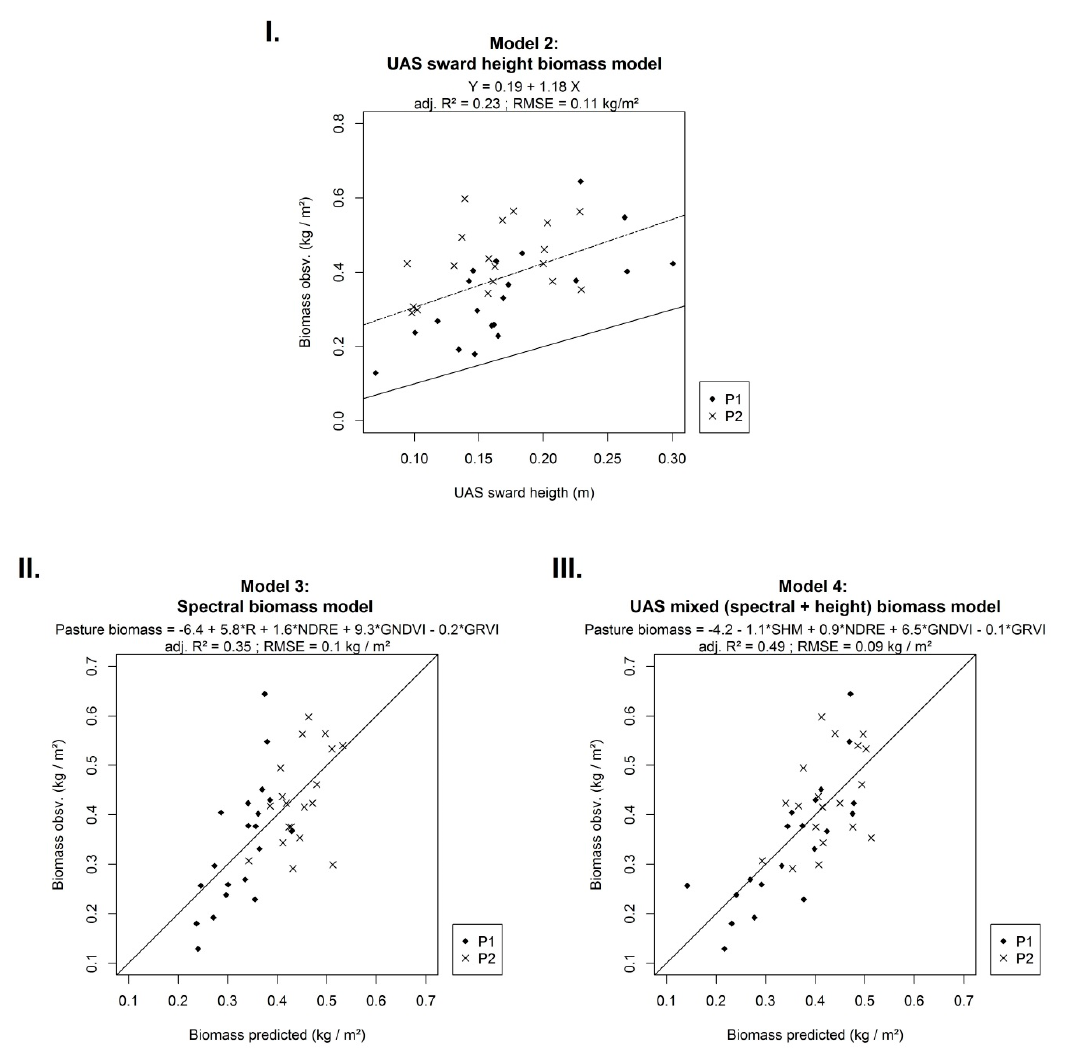
Figure 4. Comparison of different approaches of pasture biomass modeling with UAS. The Model 2 ( I ) is a biomass model based on UAS height. Model 3 ( II ) and Model 4 ( III ) are multilinear models using UAS spectral data (Model 3) and a combination of UAS spectral and height data (Model 4). For Model 2, the dashed lines represent the fitted models. The solid lines represent the 1:1 lines (i.e., x = y). Table 3. Relative importance (% of R 2 ), estimates of coefficients, and p -values of the fitted linear model with the selected variables computed for Model 4, which combines the UAS sward height and UAS spectral data.